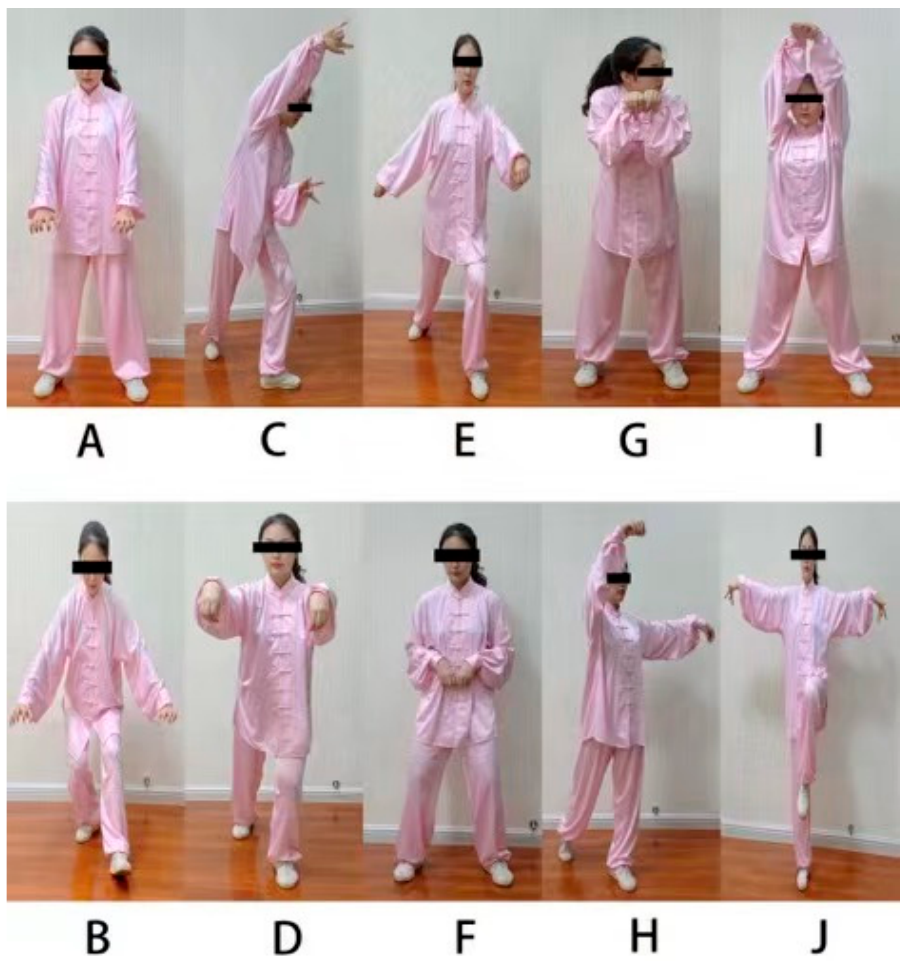
Figure 1. Ten forms of Wuqinxi Qigong. ( A ). Form 1: Raising the tiger’s paws; ( B ). Form 2: Seizing the prey; ( C ). Form 3: Colliding with the antlers; ( D ). Form 4: Running like a deer; ( E ). Form 5: Rotating the waist like a bear; ( F ). Form 6: Swaying like a bear; ( G ). Form 7: Lifting the monkey’s paws; ( H ). Form 8: Picking fruit; ( I ). Form 9: Stretching upward; ( J ). Form 10: Flying like a bird.